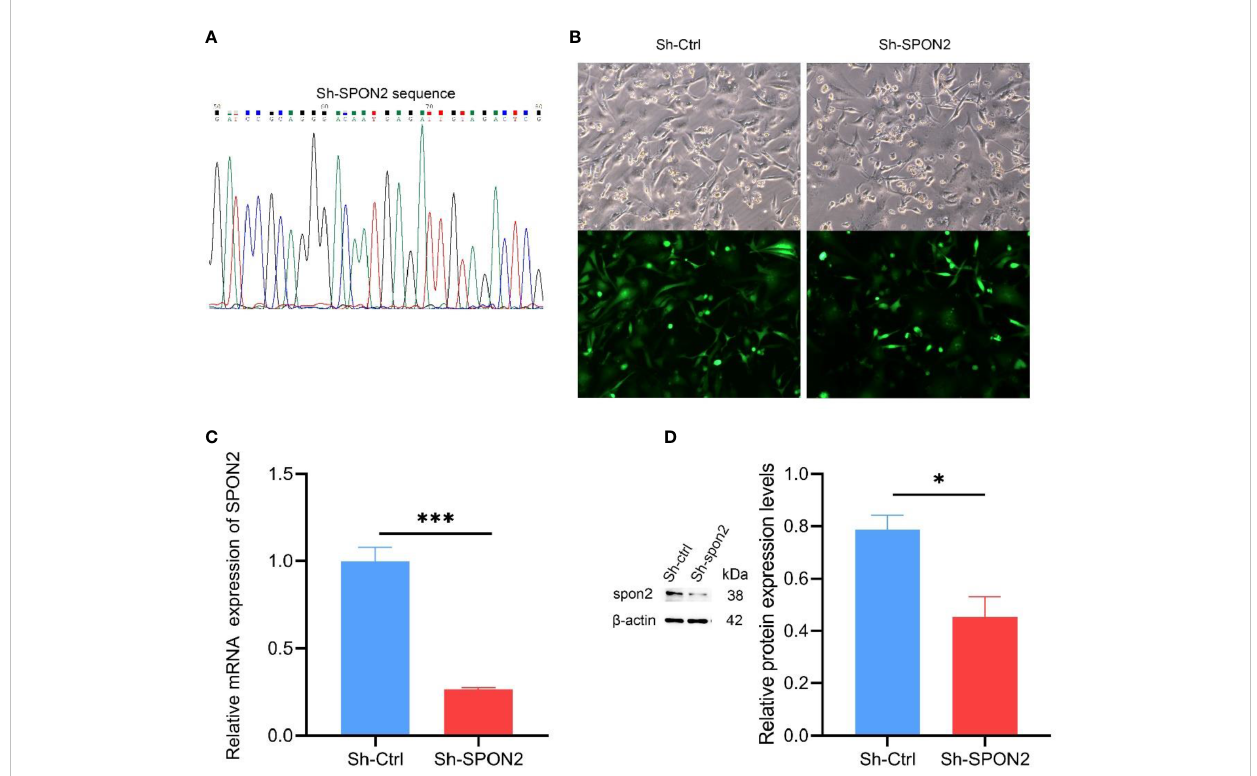
FIGURE 3 SPON2 knockdown MDA-MB-231 cells were successfully constructed. (A) The Sh-SPON2 plasmid was sequenced with the same design sequence. (B) Green fl uorescence detected by fl uorescence microscope, transfection ef fi ciency > 95%. Magni fi cation times: ×100. (C) The qPCR assay showed that the SPON2 knockdown group (Sh-SPON2) had lower SPON2 mRNA than the control virus group (Sh-Ctrl). (D) Western Blot assay showed that SPON2 protein expression was lower in the SPON2 knockdown group (Sh-SPON2) than in the control virus group (Sh-Ctrl). * P < 0.05, *** P <